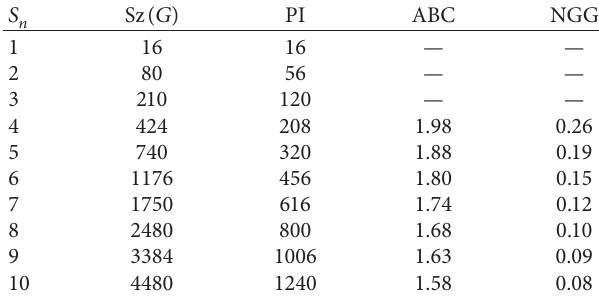
Table 22: Edge partition of para chain of n order.